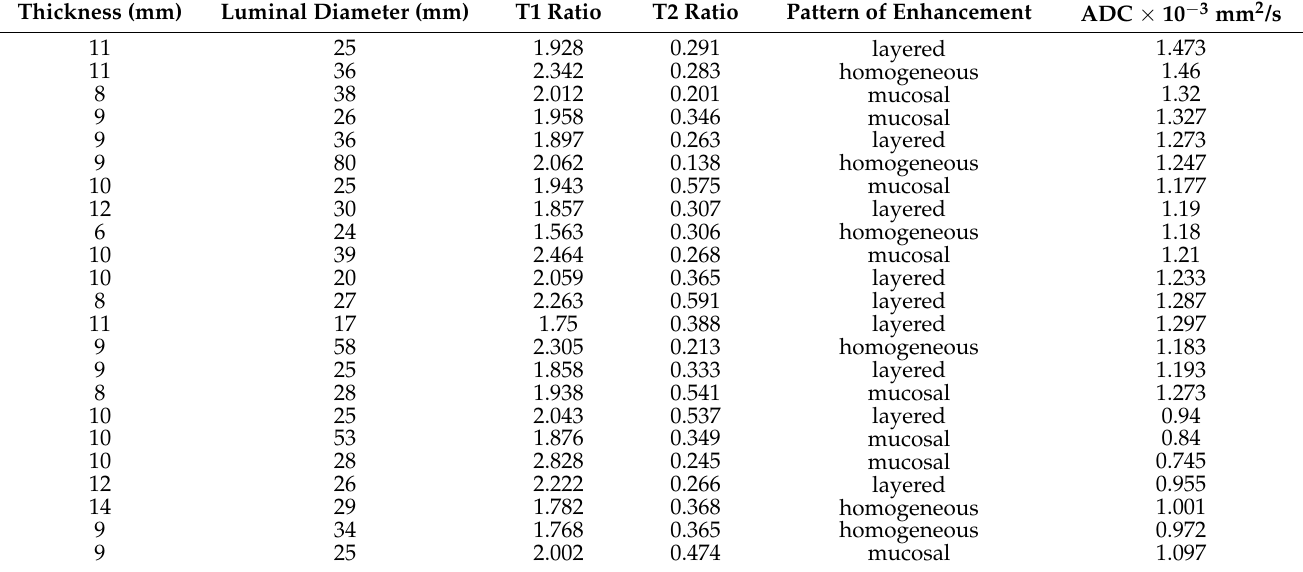
Table 3. Qualitative and quantitative MR enterography findings of bowel strictures. Thickness (mm) Luminal Diameter (mm) T1